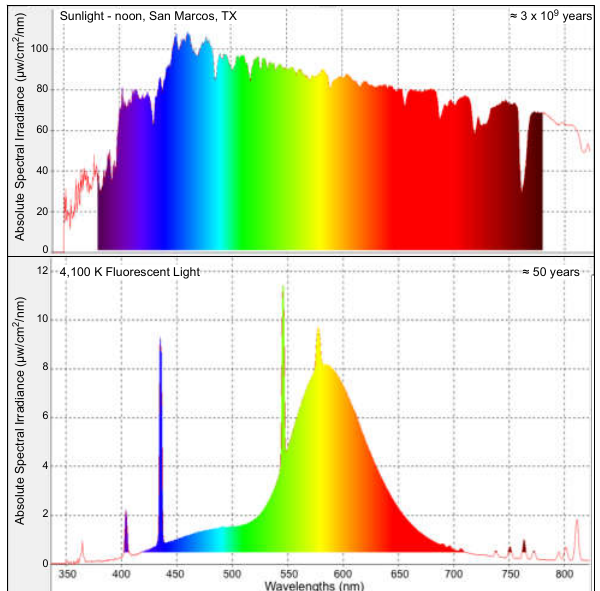
Figure 8. Examples of typical emission spectra from the sun (top) and 4100 K FL, (bottom).